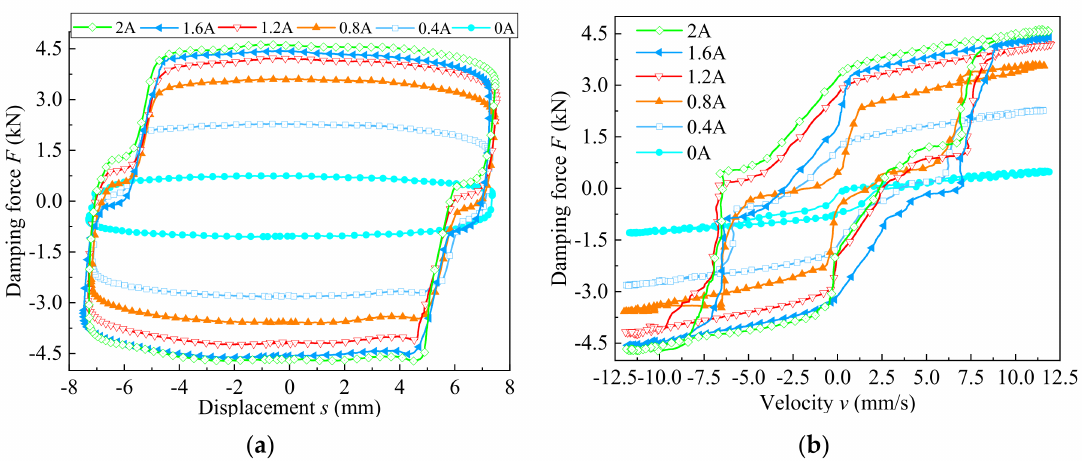
Figure 17. Damping performance of valve controlled cylinder system with radial damping gap of 0.5 mm: ( a ) force versus displacement, ( b ) force versus velocity.